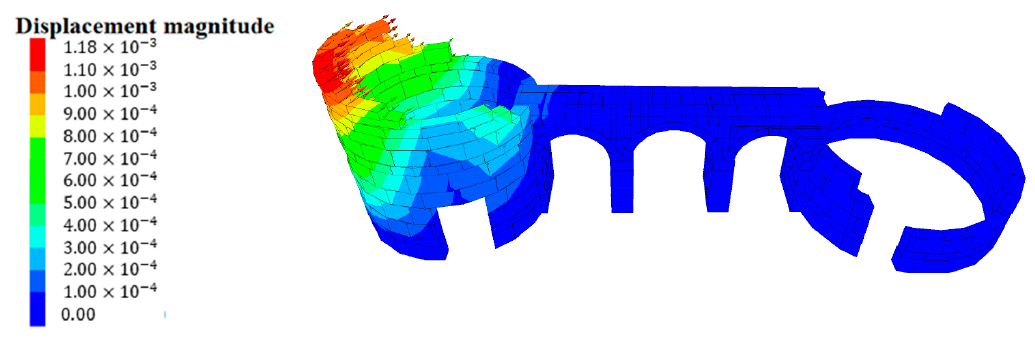
Figure 10. Eigenmode 5.